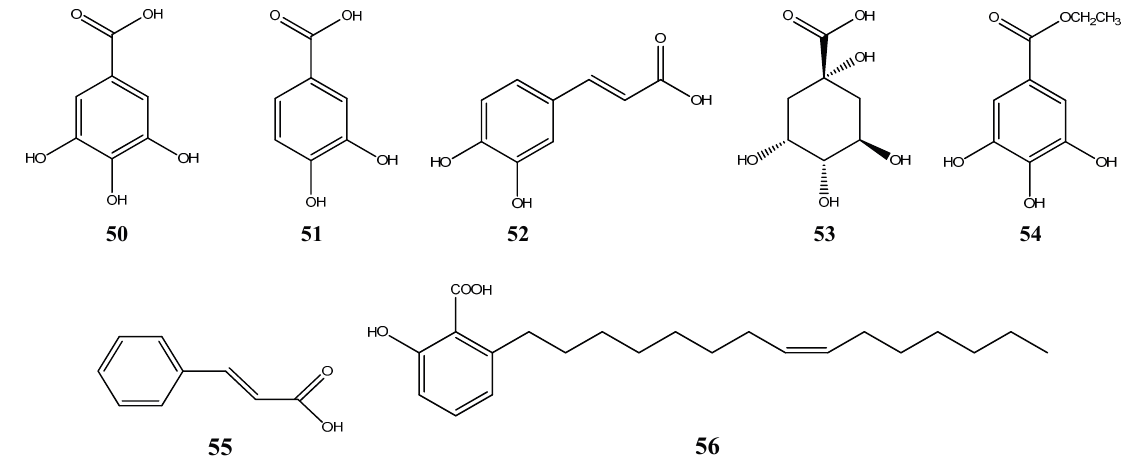
Figure 5. Organic acids isolated from Myrcia